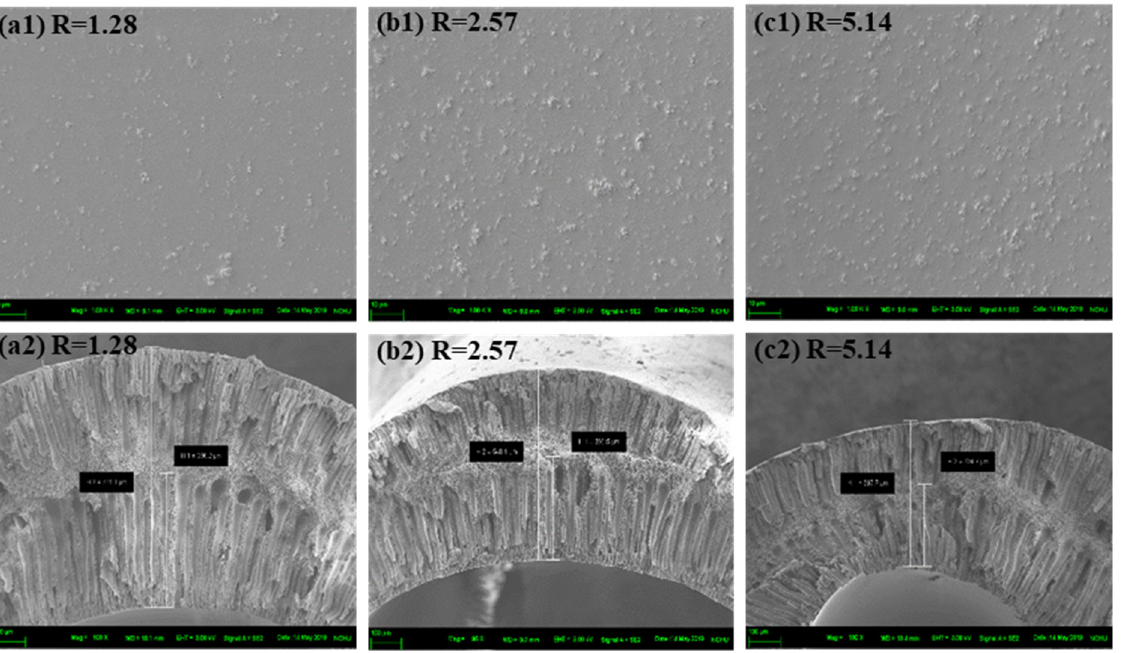
Figure 3. The inner-surface ( top ) and cross-section ( bottom ) SEM images of MMHFMs spun with different flow rate ratios: ( a1,a2 ) AG10-R1.28-1000 nm, ( b1,b2 ) AG10-R2.57-1000nm, and ( c1,c2 ) AG10-R5.14-1000nm. Table 3. The effect of the flow rate ratio on the membrane thickness.